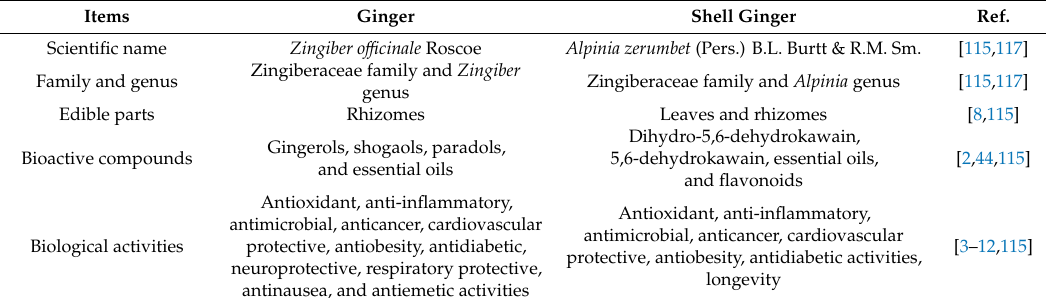
Table 5. The comparison between ginger and shell ginger.